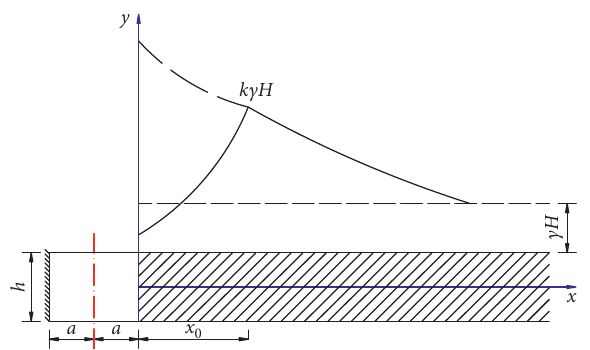
Figure 5: Calculation model of plastic zone width of coal